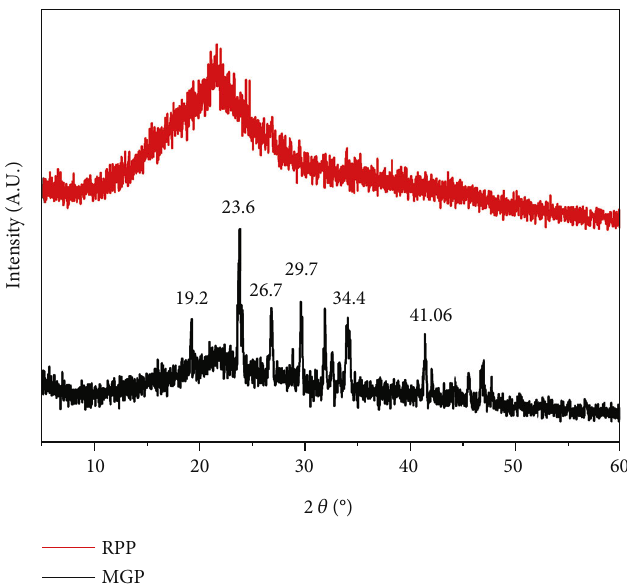
Figure 8: X-ray di ff raction spectra of marigold and rose petal powders.